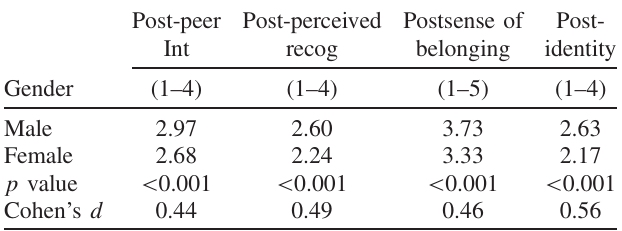
TABLE IV. Descriptive statistics of peer interaction, perceived recognition, sense of belonging, and identity for female and male students.